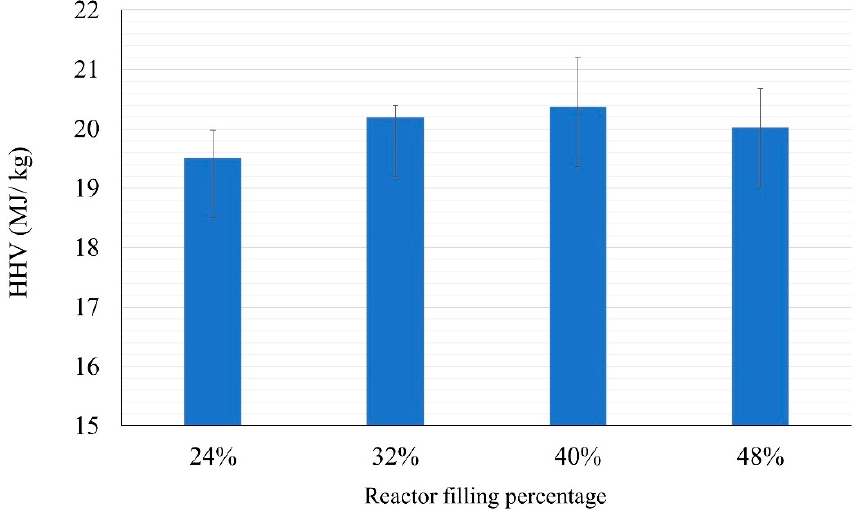
Figure 7. HHV of samples for different filling percentages of the HTC reactor.